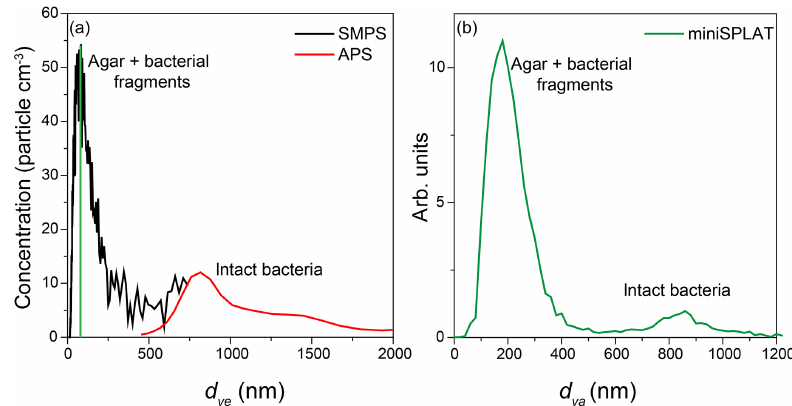
Figure 1. Size distributions of an aerosolized suspension of Pseudomonas syringae in the AIDA cloud chamber before Expansion 1, calcu- lated based on the SMPS and the APS measurements (a) and miniSPLAT (b) . The miniSPLAT small particle detection limit is denoted by the green line in panel (a) .